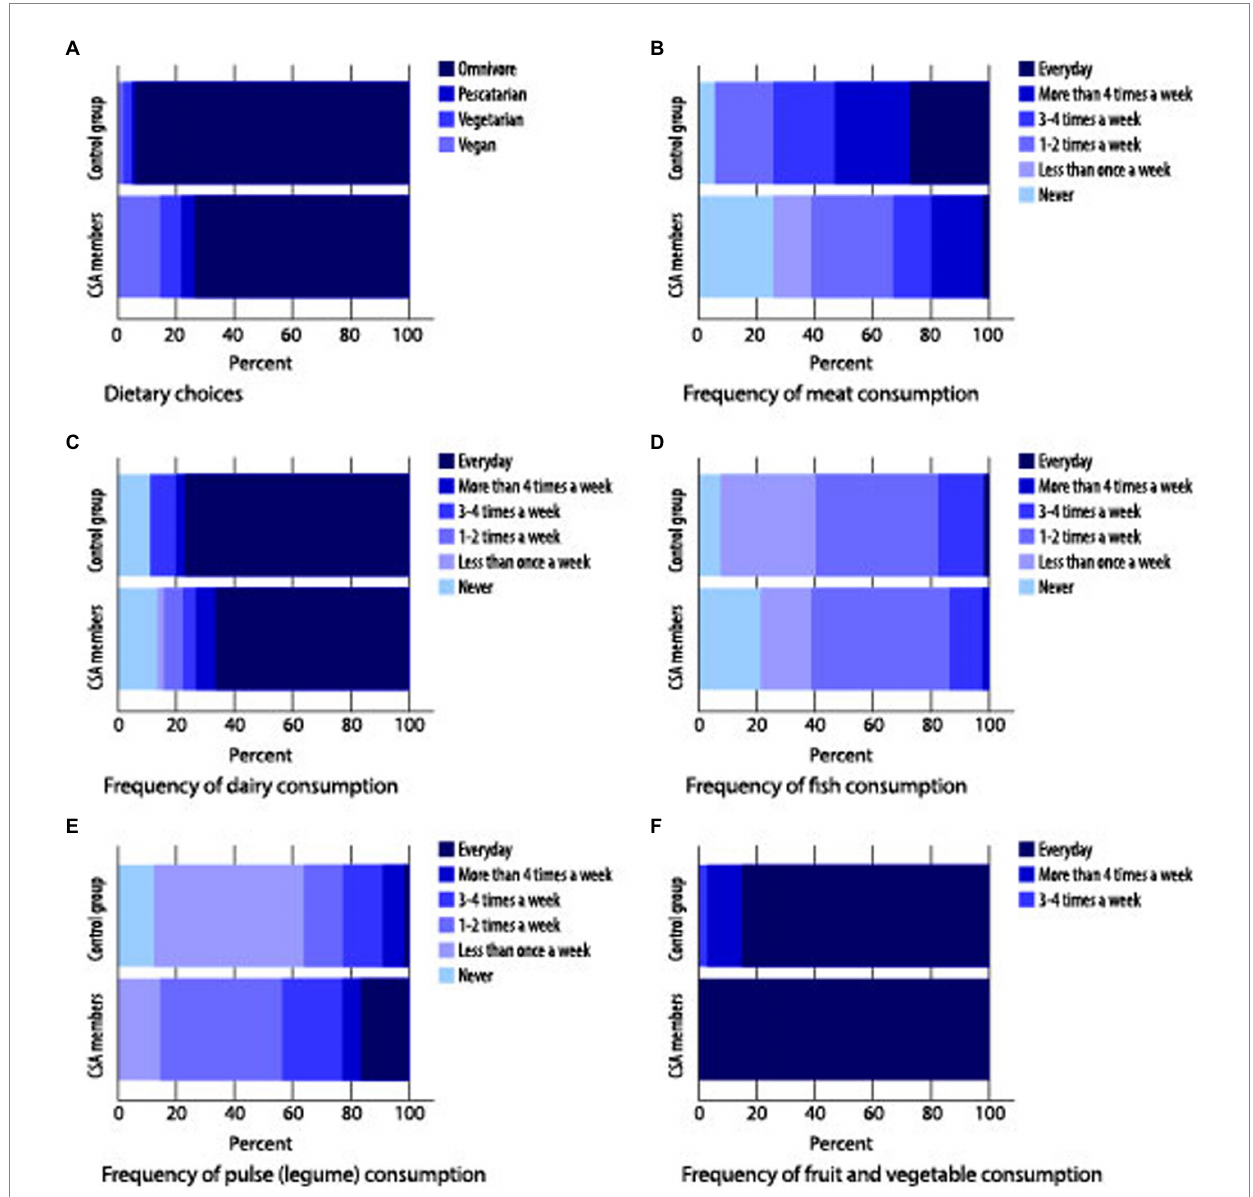
FIGURE 1 Stacked bar charts for interview questions answered by CSA members ( n = 47) and control group ( n = 67) participants showing the percentage of each group adhering to different dietary choices (A) , and the frequency of their consumption of meat (B) , dairy (C) , fish (D) , pulses (legumes; E , and fruit and vegetables (F)